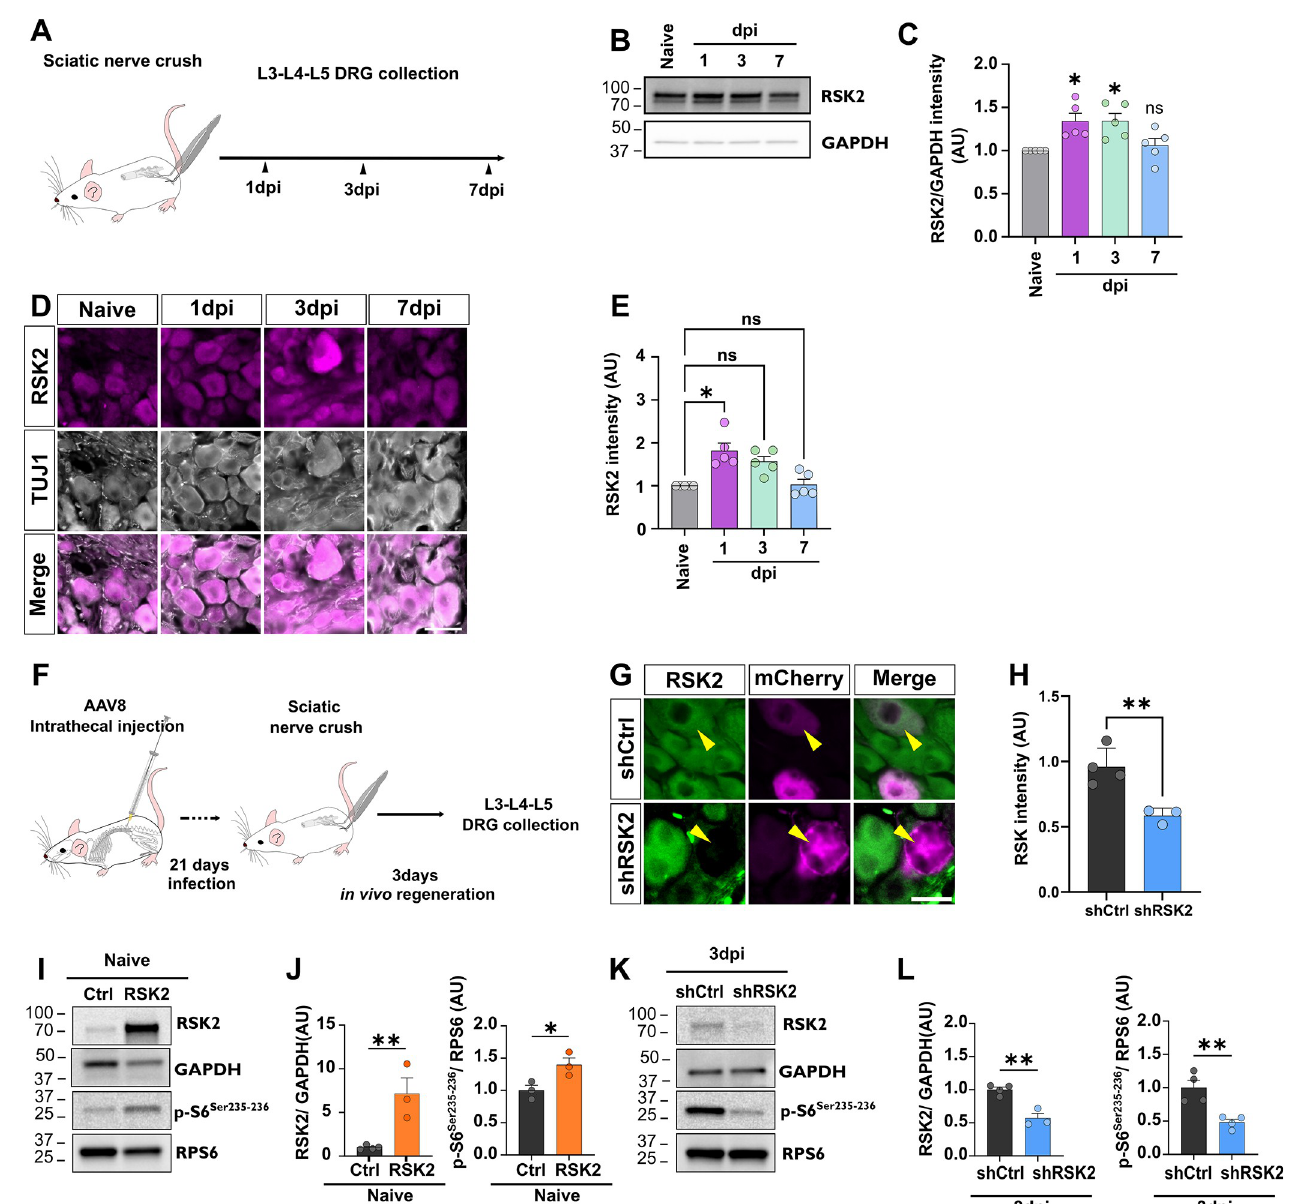
Fig 4. RSK2 regulates RPS6 Ser235-236 phosphorylation in mature DRG. (A) Workflow of experiment. (B) Western blot showing up-regulation of RSK2 expression upon sciatic nerve injury. (C) Quantification of B (mean ± SEM, one-sample t test, N = 5 animals per group). (D) Representative images of DRG sections from intact, 1 dpi, 3 dpi, or 7 dpi conditions labeled with anti-RSK2 (in magenta) and anti-Tuj1 (in gray). Scale bar: 50 μ m. (E) Quantification of D (one-way ANOVA, Dunn’s multiple comparisons test, N = 5 animals per group). (F) Timeline of the experimental procedure to investigate in vivo the role of RSK2 in RPS6 phosphorylation. (G) Representative images of infected DRG by shCtrl or shRSK2 labeled with anti-RSK2 (in green) and anti-RFP (in magenta). Scale bar: 50 μ m. (H) Quantification of G (mean ± SEM, unpaired t test, N = 3–4 animals per group). (I) Western blot showing that in vivo overexpression of RSK2, in naive DRG, induces RPS6 phosphorylation on Ser235-236 without sciatic nerve injury. (J) Quantification of I (mean ± SEM, one-sample t test, N = 3–4 animals per group). (K) Western blot showing in vivo inhibition of RSK2 in preconditioned DRG, 3 days after sciatic nerve injury, inhibits RPS6 phosphorylation on Ser235-236. (L) Quantification of K (mean ± SEM, one-sample t test, N = 3–4 animals per group). *** p < 0.001, ** p < 0.01, * p < 0.05, ns: not significant. Raw data can be found in Supporting information (S1 Data and S1 Raw Images). dpi, days post-injury; DRG, dorsal root ganglion; RPS6, ribosomal protein